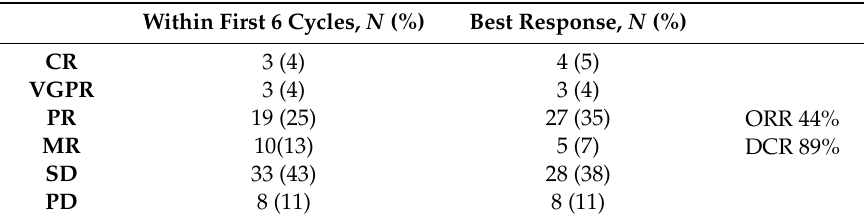
Table 4. Evaluation of e ffi cacy of PomaD in